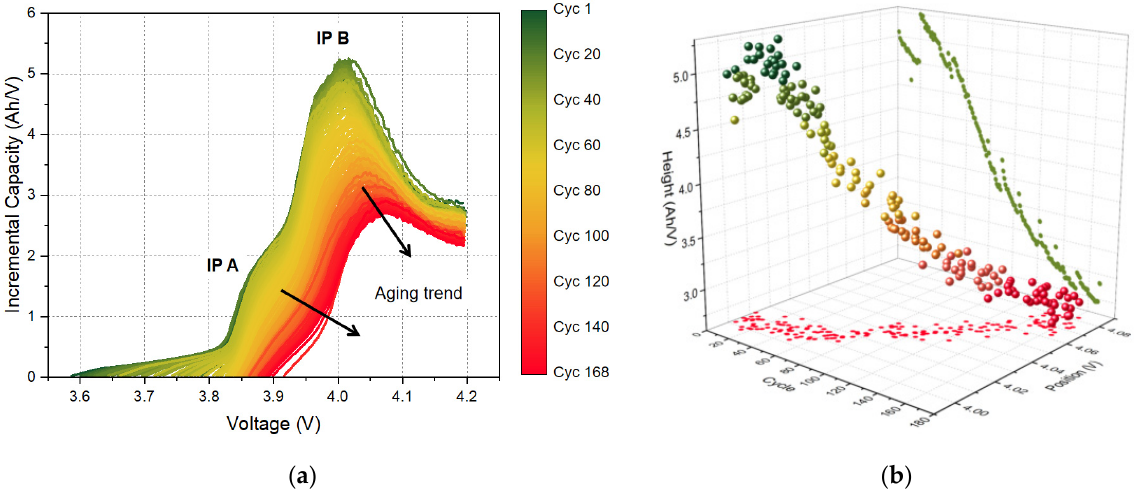
Figure 4. IC curve and HIs of B05 in different charging cycles: ( a ) IC curve; ( b ) Height and position of IP B as two HIs.